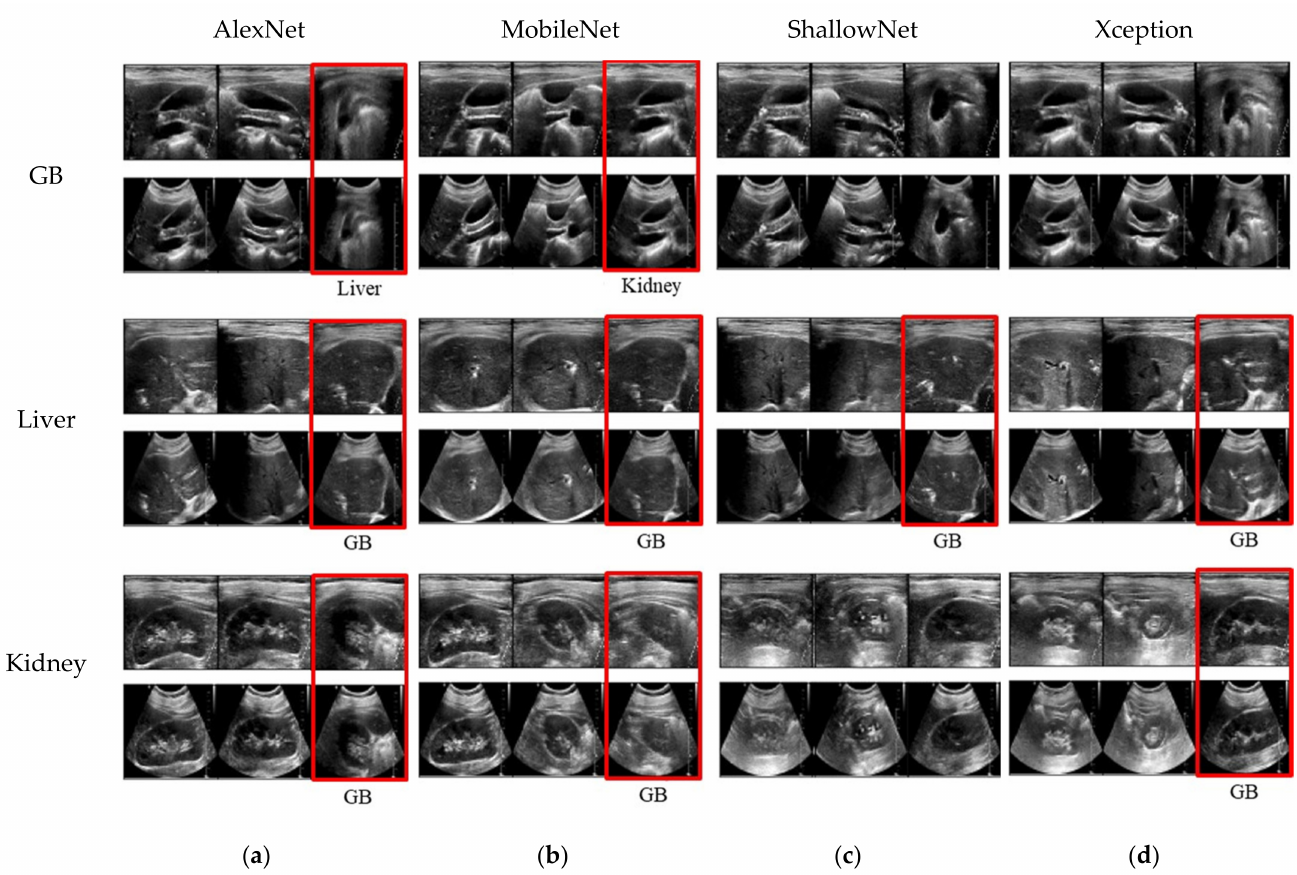
Figure 7. Image pairs categorized from abdomen to gallbladder, liver, and kidney. The upper row in each organ is the result obtained by the network trained by the RSC method, and the lower row is obtained by the network trained by the USI training dataset with down-sampled DSC images. Each column depicts the result of ( a ) AlexNet, ( b ) MobileNet, ( c ) ShallowNet, and ( d ) Xception. Red boxes denote errors in the results of USI training dataset, and a misclassified organ is specified below the